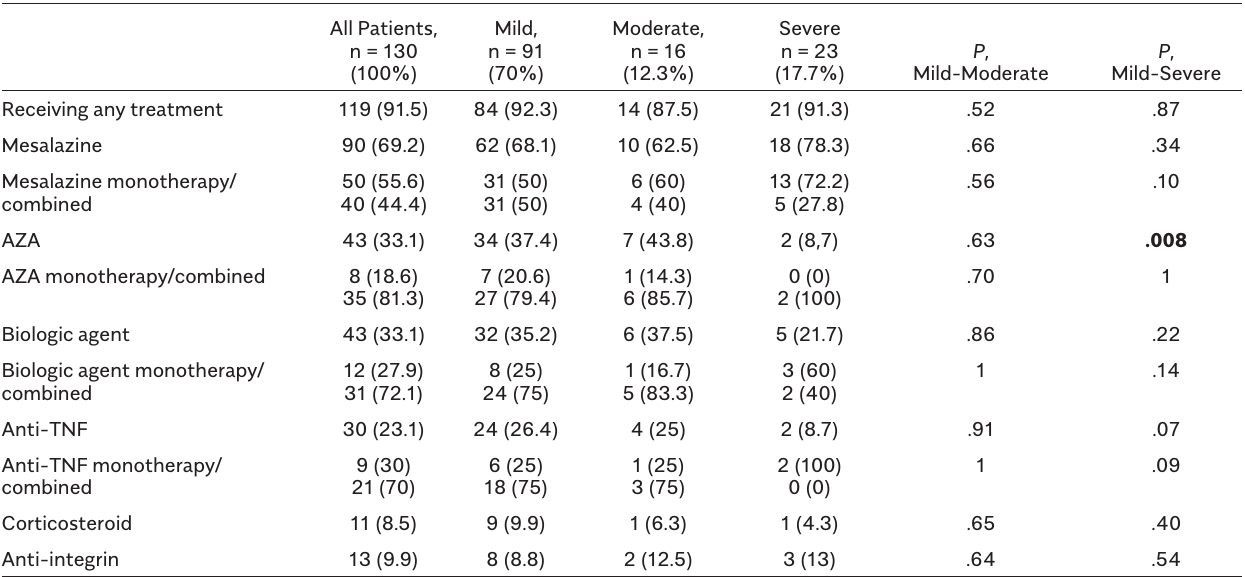
Table 2. Drugs Comparison of Mild, Moderate, and Severe COVID-19 Groups